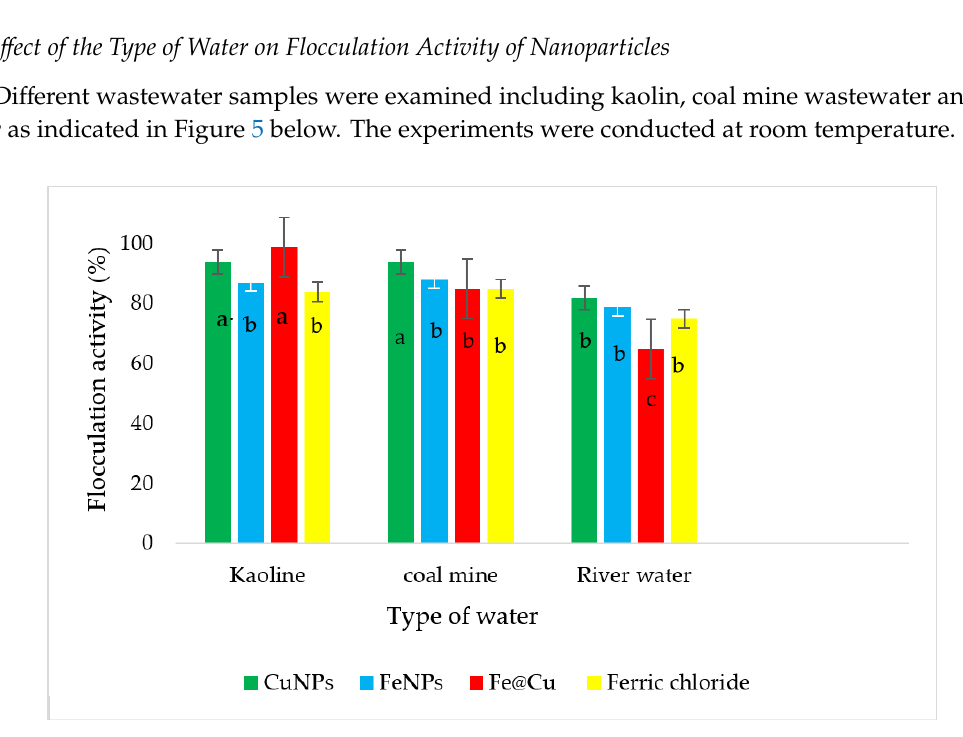
Figure 5. Flocculating efficiency of CuNPs, FeNPs and Fe@Cu nanoparticles and ferric chloride using kaolin clay, coal mine water and river water all data was collected in triplicates and the error bars in